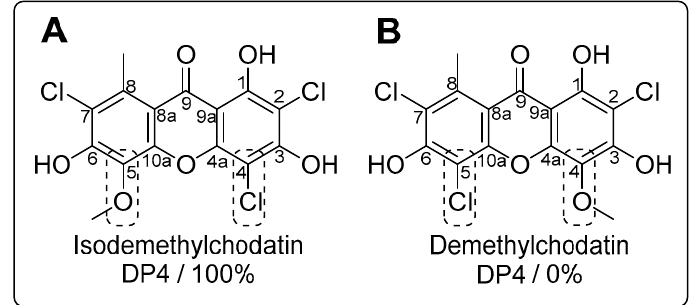
Figure 2. Chemical structures of the two possible regioisomers: tentative structure of isodemethylchodatin ( A ) and demethylchodatin ( B ) along with their respective DP4 probabilities.